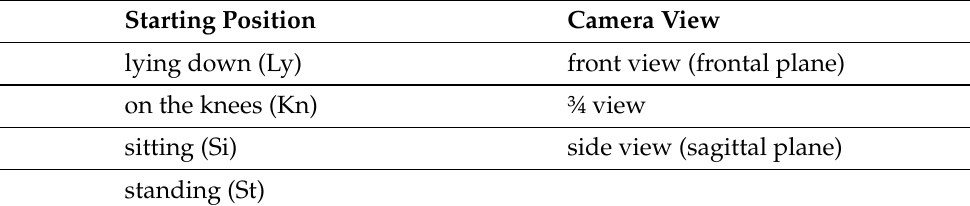
Figure 2. Orientation of the camera relative to the subject. Camera view options: front, ¾ and side [24]. Table 2. Categorization of